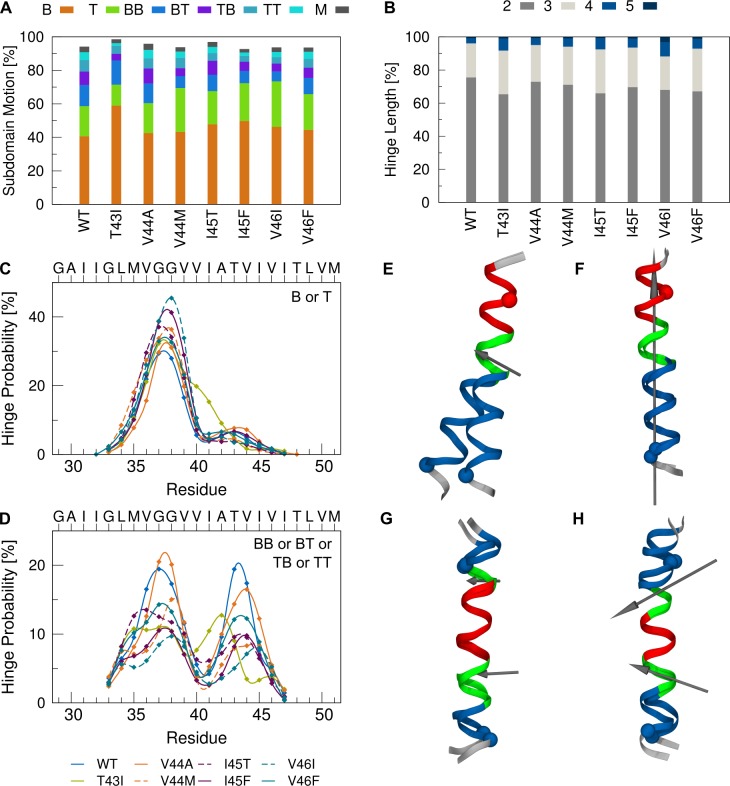
Decomposition of backbone dynamics.(A) Probability of hinge bending and twisting motions. Motions coordinated by a single flexible hinge are referred to as type Bend 1 (B) and Twist 1 (T), respectively. Bending and/or twisting around a pair of hinges is characterized by four combinations of bending (B) and twisting (T) (motion types BB, BT, TB, TT). Motions coordinated by more than 2 hinges are grouped in category M. (B) Number of hinge residues utilized for single-hinge motions. (C, D) Probability by which a residue is identified as a hinge site in the single-hinge (C) and double-hinge (D) bending and twisting motions. (E-F) Examples for bending (E) and twisting (F) around a single hinge. (G-H) Examples of correlated bending (G) and mixed bending/twisting (H) around a pair of hinges. Helical segments moving as rigid domains are coloured in blue and red, the hinge residues are highlighted in green. Screw axes are shown in grey. A larger projection of the screw axis with respect to the helix axis indicates a higher percentage of twisting. Spheres label the Cα atoms of G33 in TM-N and L49 in TM-C.